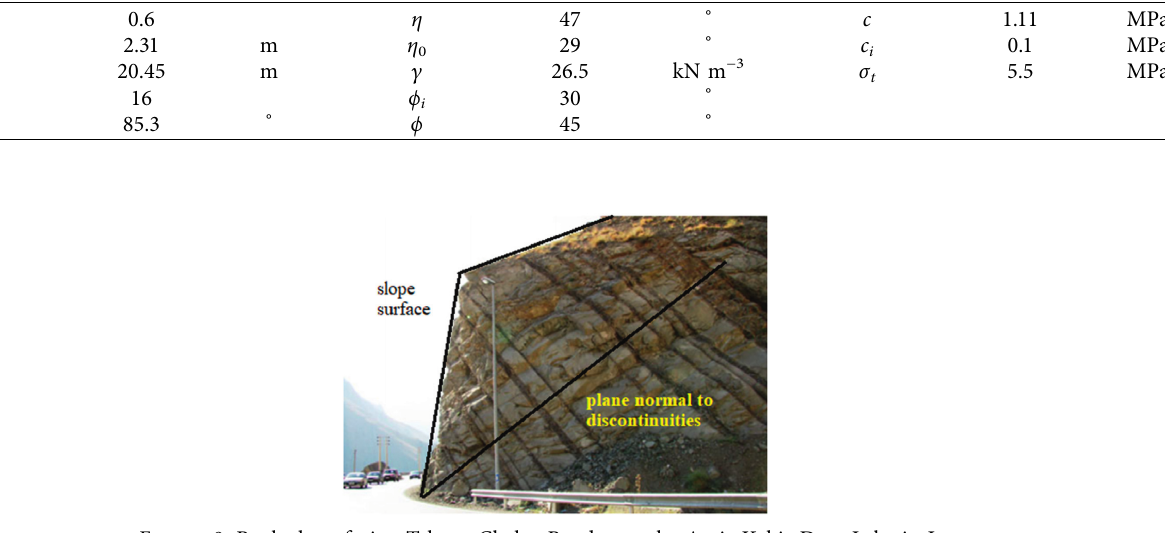
Figure 8: Rock slope facing Tehran-Chalus Road near the Amir-Kabir Dam Lake in Iran. Table 4: Result comparisons of rock slope facing the Tehran-Chalus Road obtained using different methods.